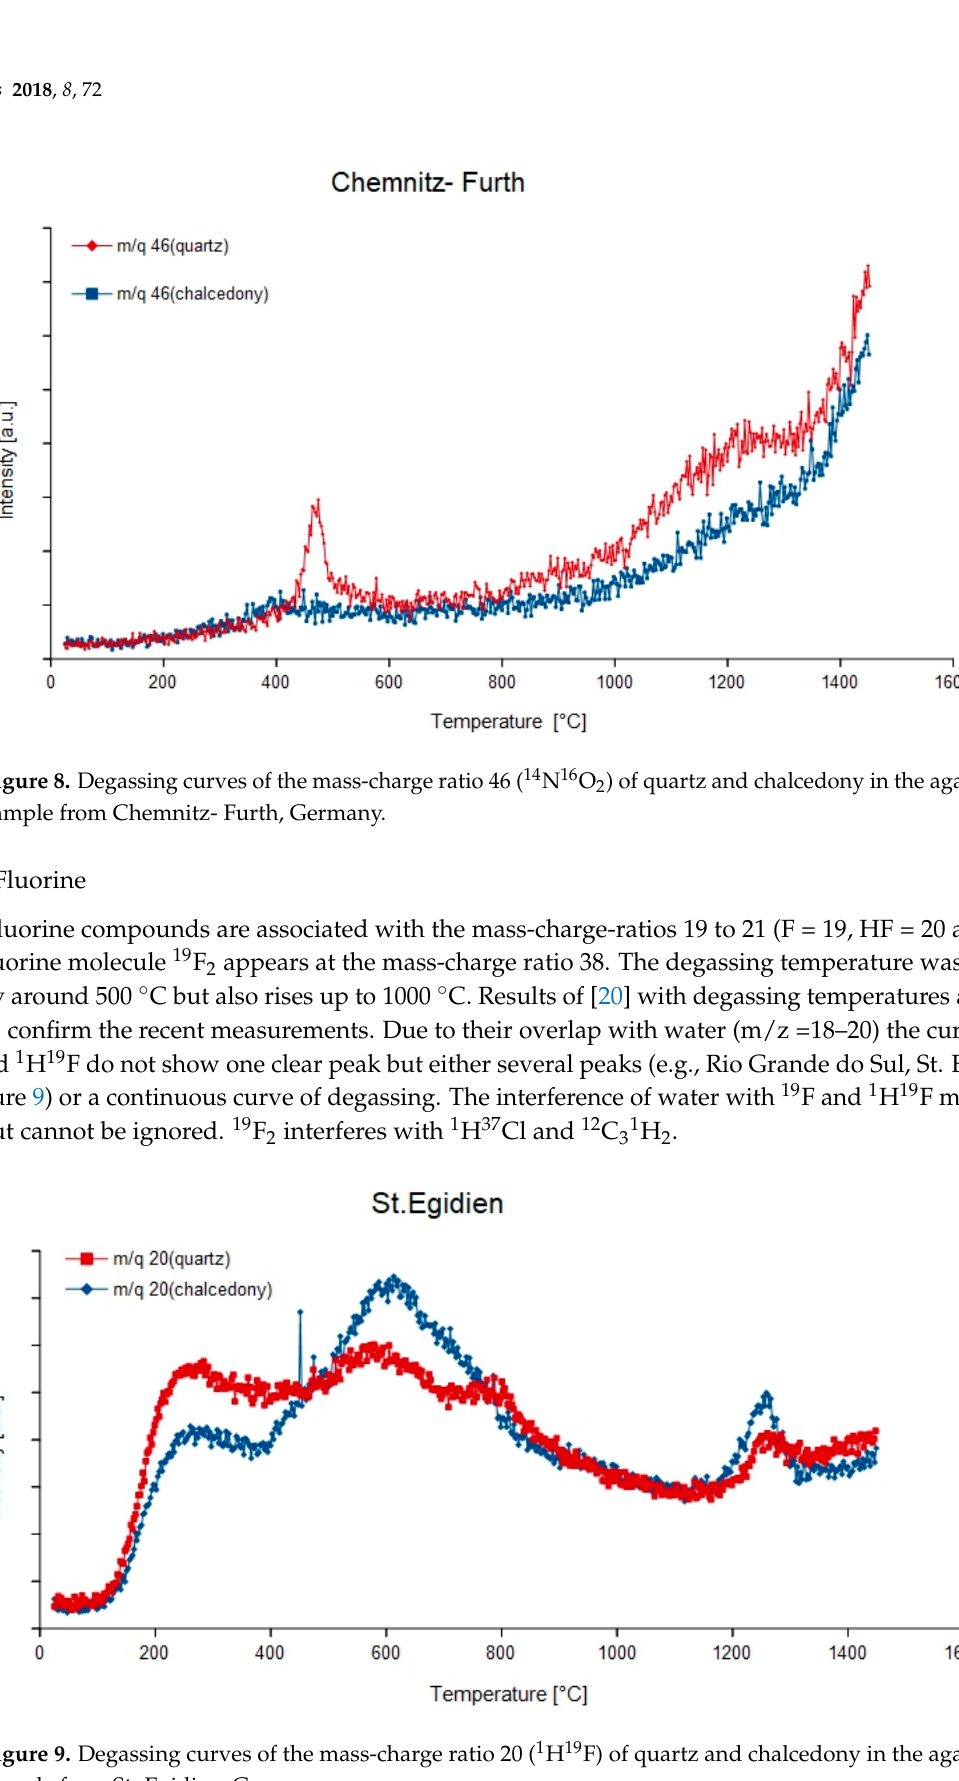
Figure 7. Continuous degassing curves of mass-charge ratio 30 ( 14 N 16 O) of the quartz and chalcedony parts in the agate from Zwickau, Germany.